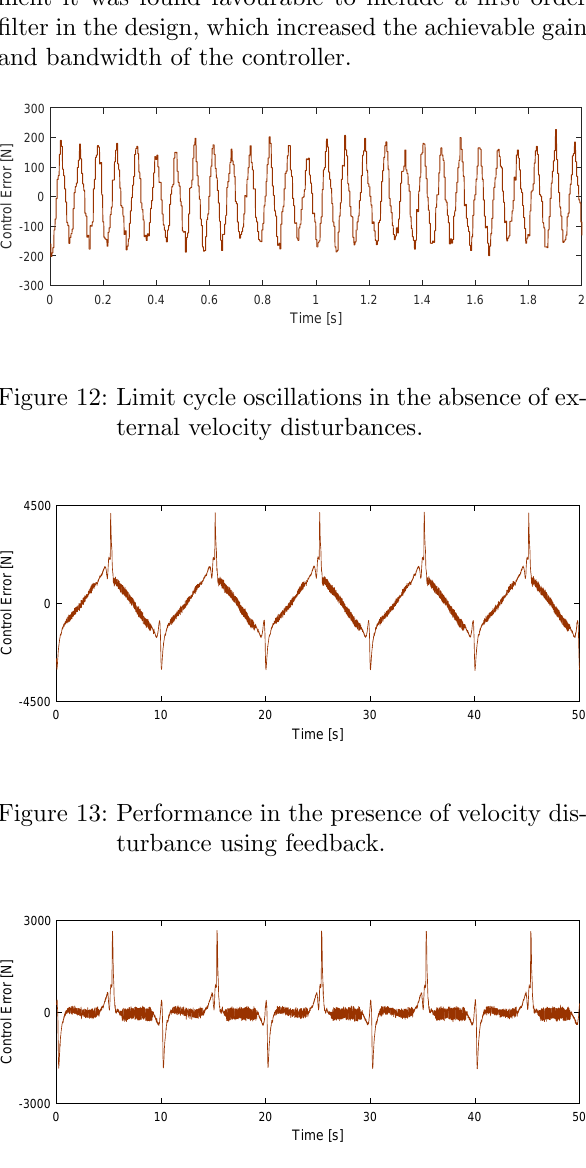
Figure 14: Performance in the presence of velocity dis- turbance using feedback and feed